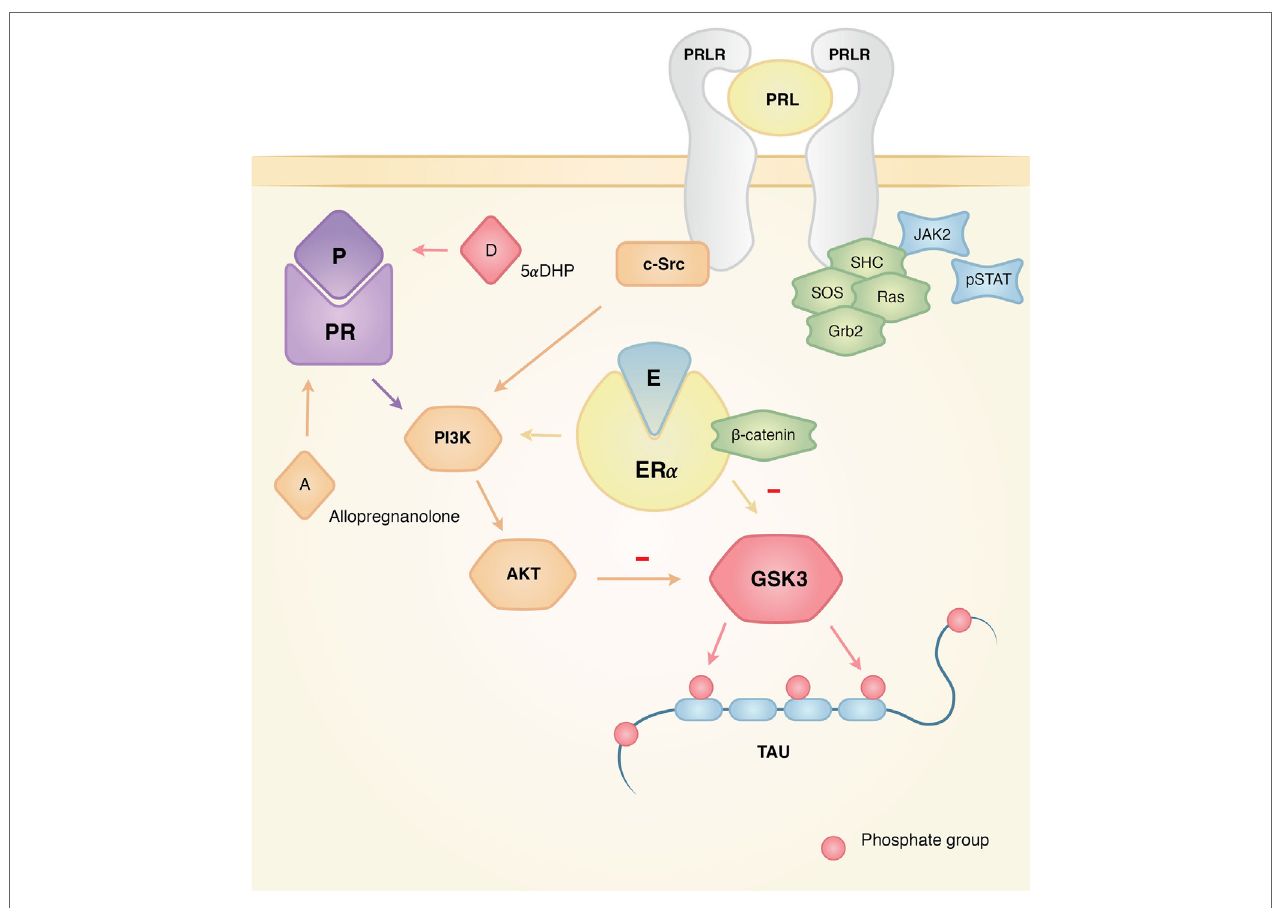
FiGURe 2 | Actions of estrogen, progesterone, and prolactin on tau phosphorylation. Interacting mechanisms of hormone action that affect the dynamics of tau phosphorylation. The three hormones have documented activity in the activation of Akt that makes GSK3 inactive, which results in the inhibition of tau phosphorylation for this particular kinase. Since GSK3 has been linked in the pathological development of Alzheimer’s disease (AD), the interplay between these hormones, their pathways, and GSK3 might explain why the absence of hormones could account for the higher risk of developing AD. On the other hand, the presence of hormones like prolactin might prove neuroprotective for the neurodegeneration of the female